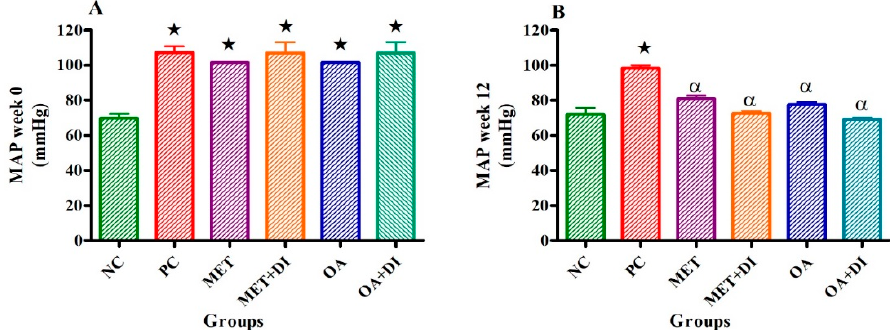
Figure 2. Effects of OA and Met ( n = 6, per group) on mean arterial pressure of rats that continued with HFHC diet and those that changed diet or had diet intervention at week 0 ( A ) and week 12 ( B ) respectively. Values are presented as standard error of mean ± SEM. = p < 0.05 denotes comparison with NC; α = p < 0.05 denotes comparison with PC.